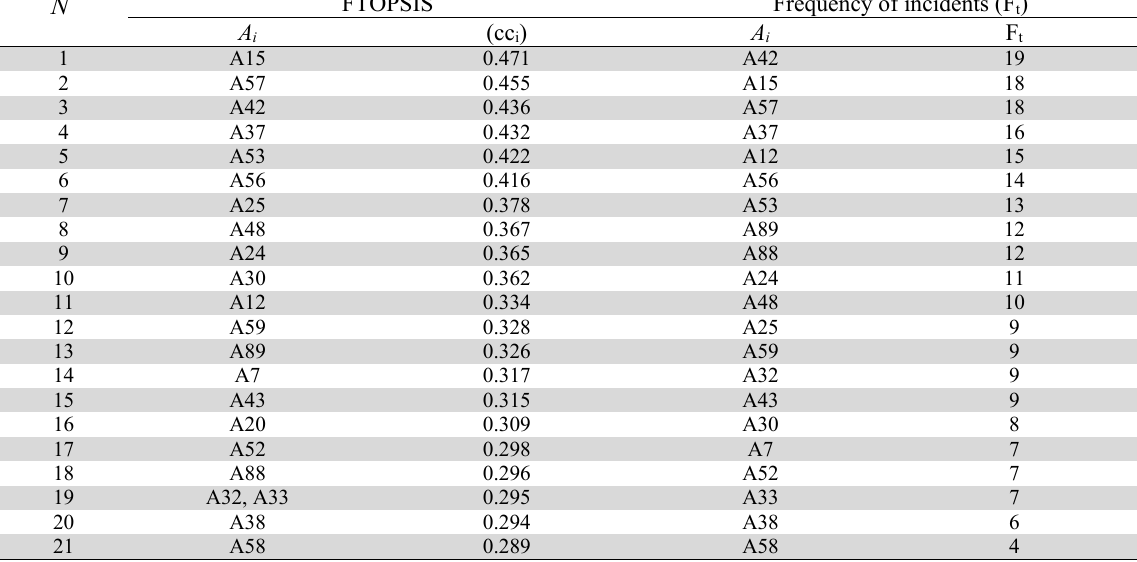
The summary of the ranking black spots based on tangent distance